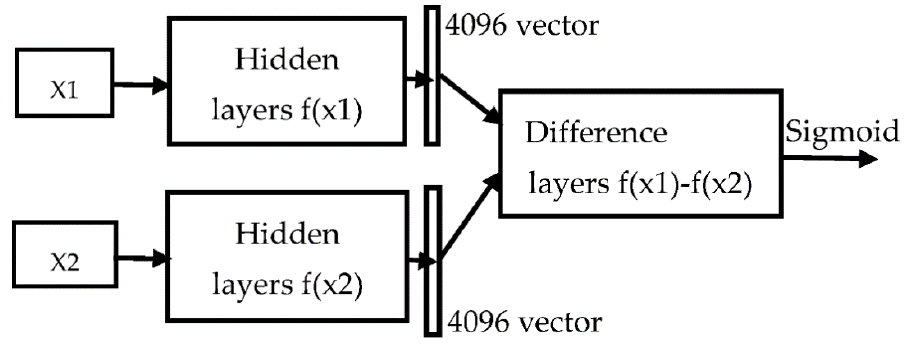
Figure 4. Siamese network model.